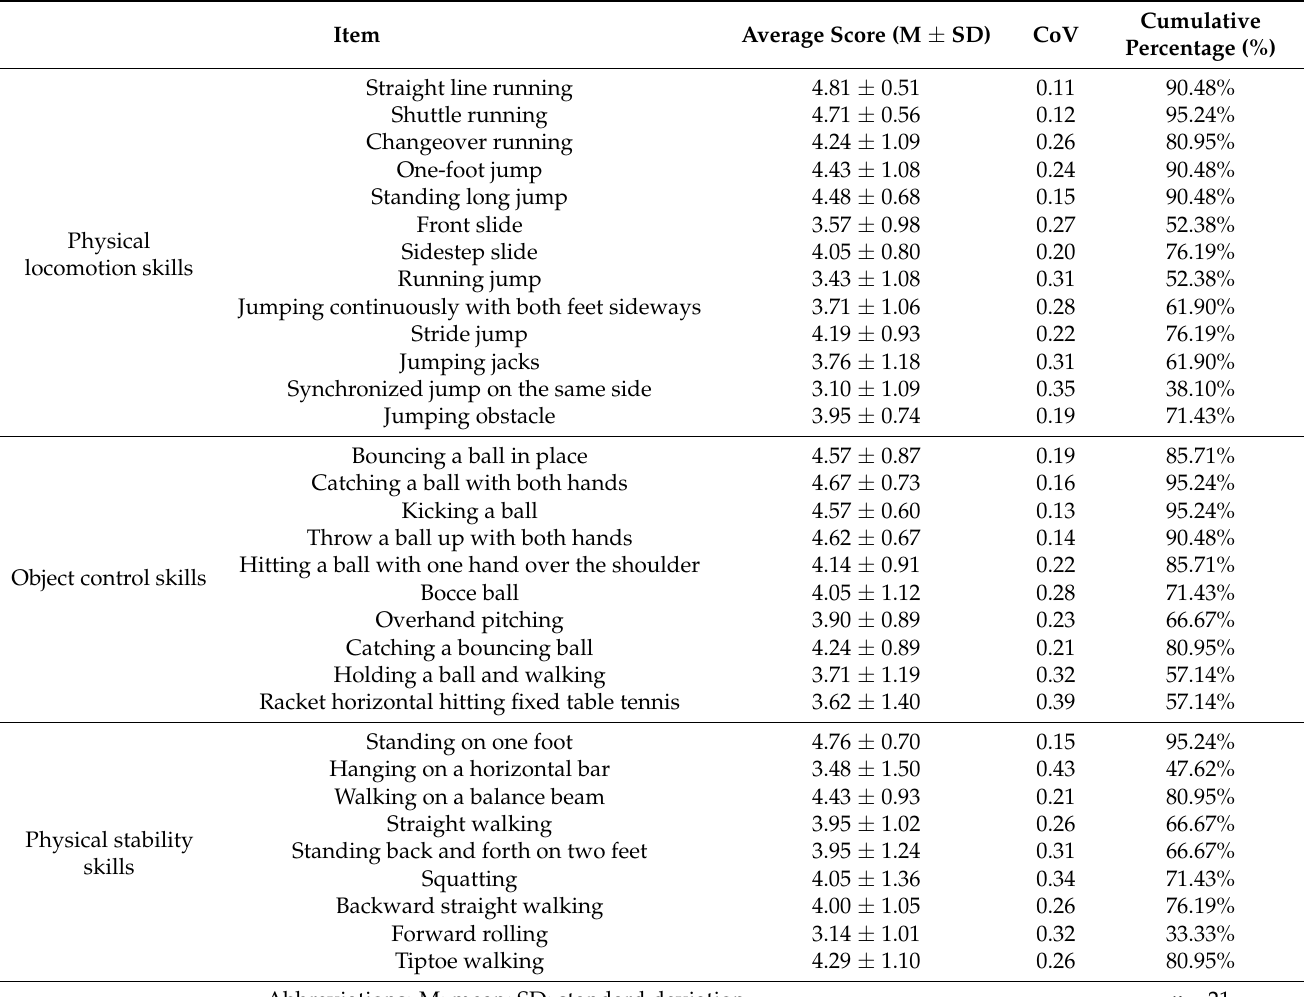
Table 4. Results of the questionnaire